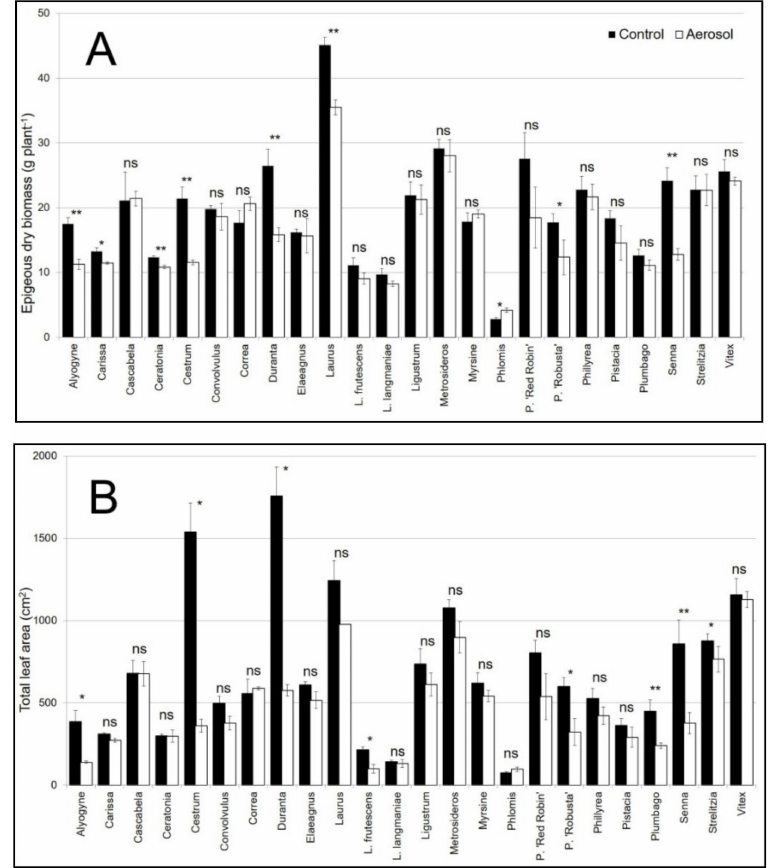
Figure 1. Epigeous dry biomass ( A ) and total leaf area ( B ) in twenty-four species of ornamental shrubs exposed to salt spray for 60 days. The vertical bars represent the S.E. of the means. Data were subjected to one-way ANOVA, and di ff erences among means were determined for each species using Tukey’s post-test ( p ≤ 0.05); n.s. not significant; * significant at p < 0.05; ** significant at p <